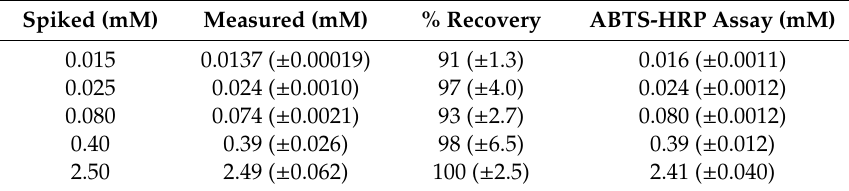
Table 1. Spike recoveries for H 2 O 2 in bovine calf serum measured using N-SPCE at − 0.4 V in 0.05 M phosphate bu ff er (pH 7.4) and comparison of amperometric detection to an ABTS-HRP-based assay